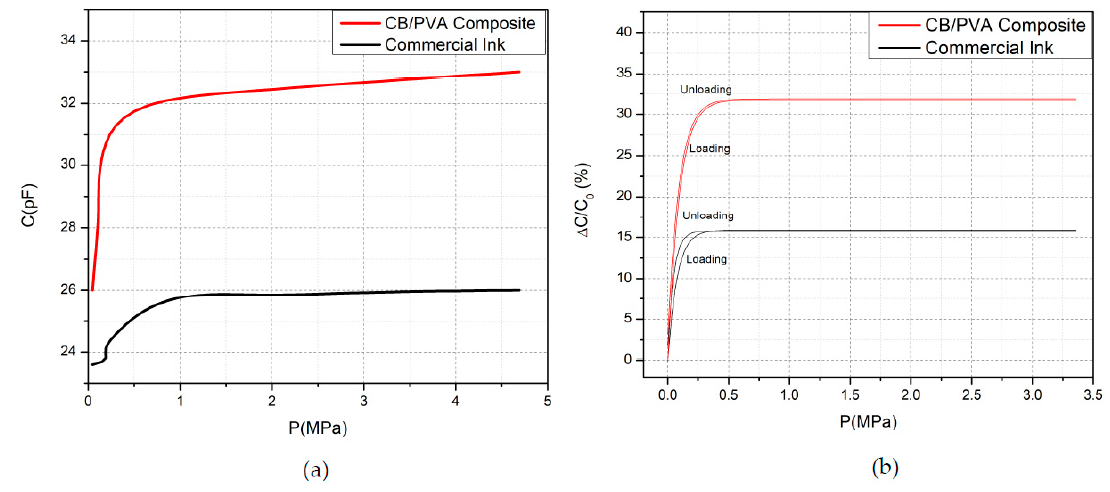
Table 2. Pressure sensitivity of the sensors in different pressure ranges.